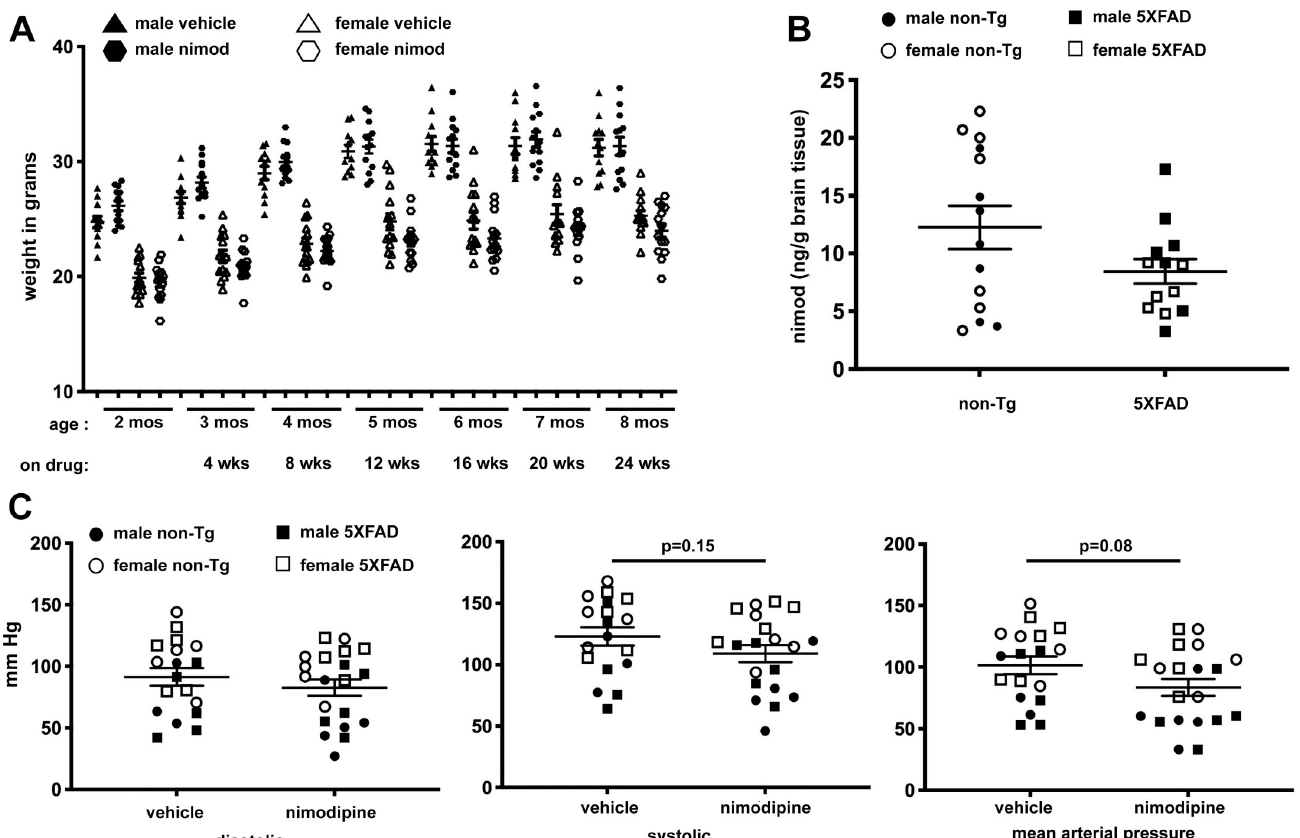
Fig 1. Oral nimodipine accumulates in the brain and has minimal effect on blood pressure. (A) 5XFAD and non-transgenic control mice were weighed at 2 months and started on nimodipine diet, then weighed monthly until brain harvest at 8 months of age. Nimodipine treatment did not affect weight gain or maintenance in either males or females. (B) Nimodipine concentration in the brains of nimodipine-treated mice were determined by mass spectrometry. While there was notable animal to animal variation, there was no significant difference in nimodipine concentration between the genotypes or sexes. (C) At 8 months of age, mice were subjected to blood pressure measurement using a tail cuff system. We observed a non-significant trend for reduced blood pressure in nimodipine- treated mice.